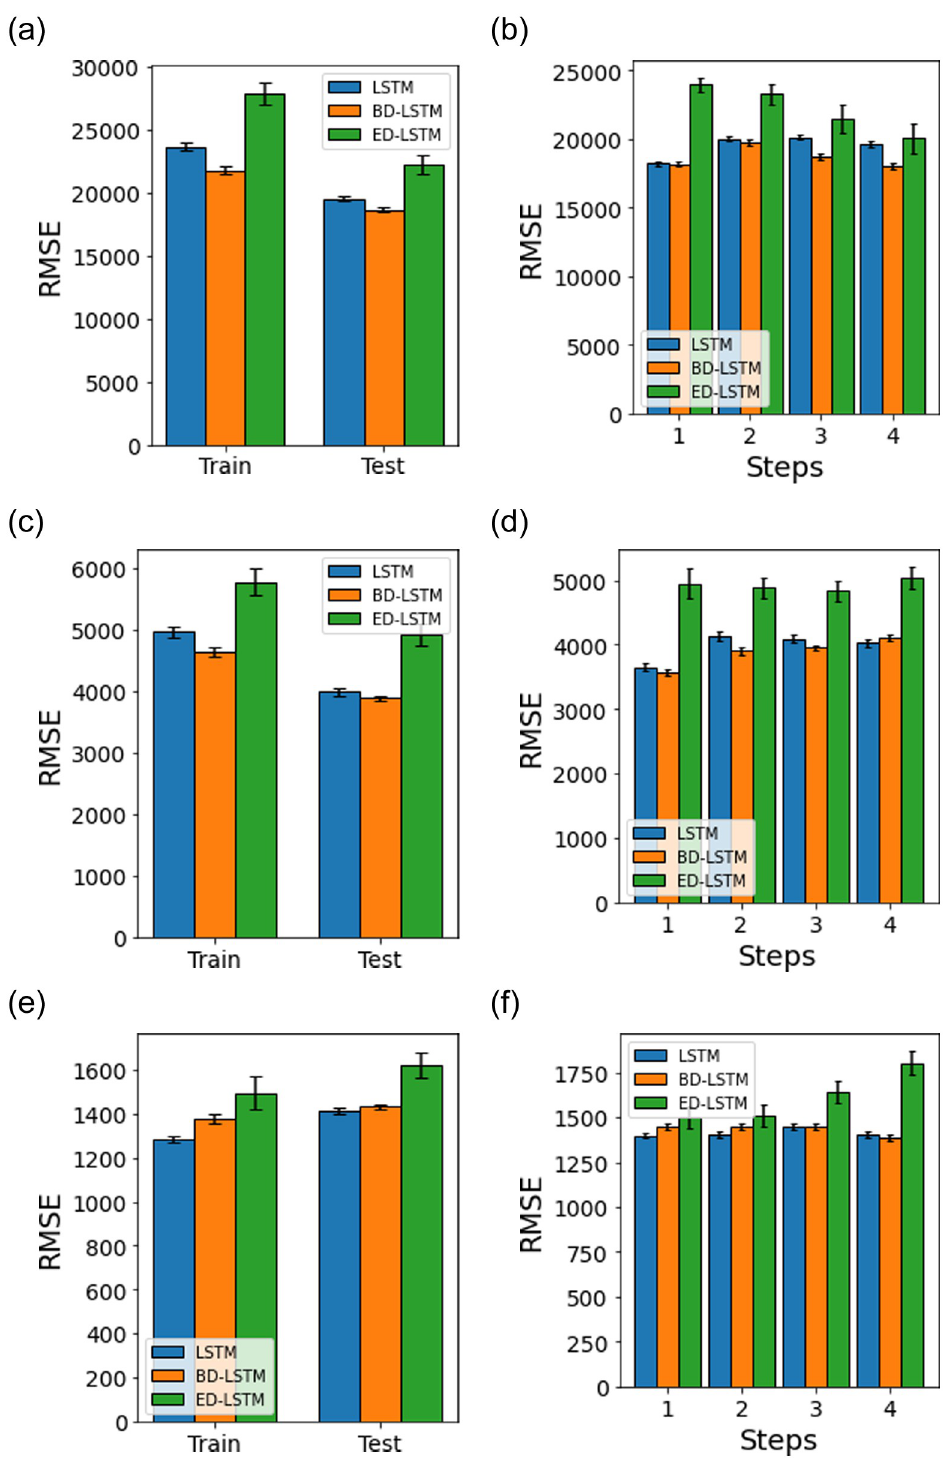
Fig 10. Multivariate model performance accuracy (RMSE) using LSTM, BD-LSTM and ED-LSTM with a random- split for the train and test datasets, and test prediction horizons (steps). The error bars represent the mean and 95% confidence interval for 30 experiment